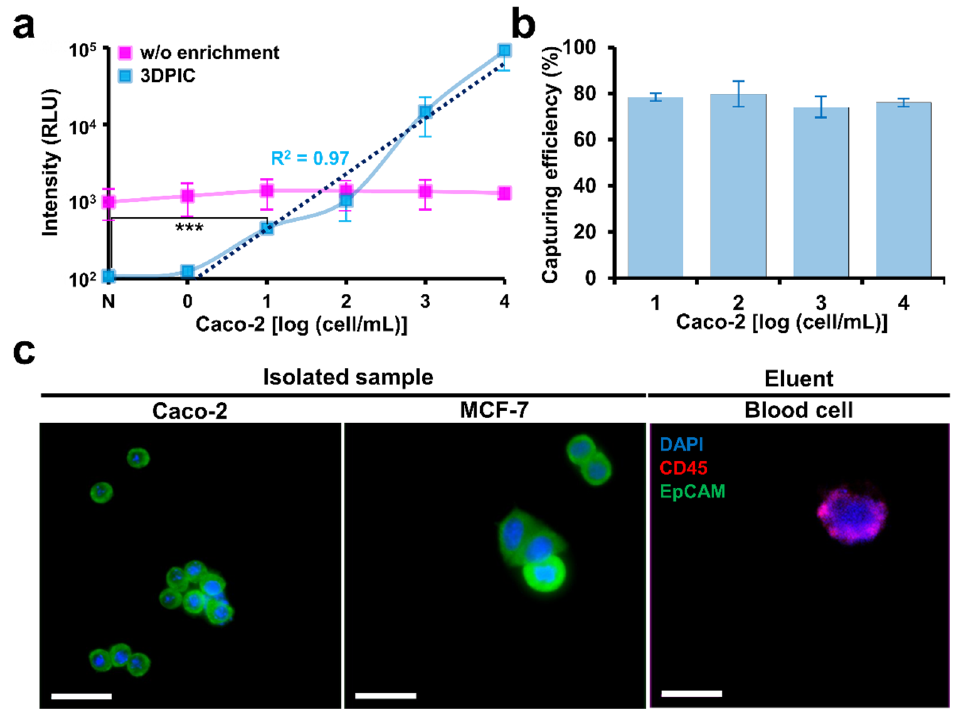
Figure 5. Spike test in blood. ( a ) Luminescence change for CTCs at different concentrations (1–10 4 cells/mL) in blood in 3DPIC. ( b ) Capturing efficiency at different concentrations of CTCs (1–10 4 cells/mL) in 1 mL of blood in 3DPIC. ( c ) Immunostaining of CTCs (Caco-2 and MCF-7 cells) and blood cells after capturing and isolation. CTCs were in the isolated sample, and blood cells were in the eluent. The cells were stained using CD45 (red), EpCAM (green), and DAPI (blue). The scale bar is 50 μ m. Student’s t -test, *** p < 0.001, n = 3.